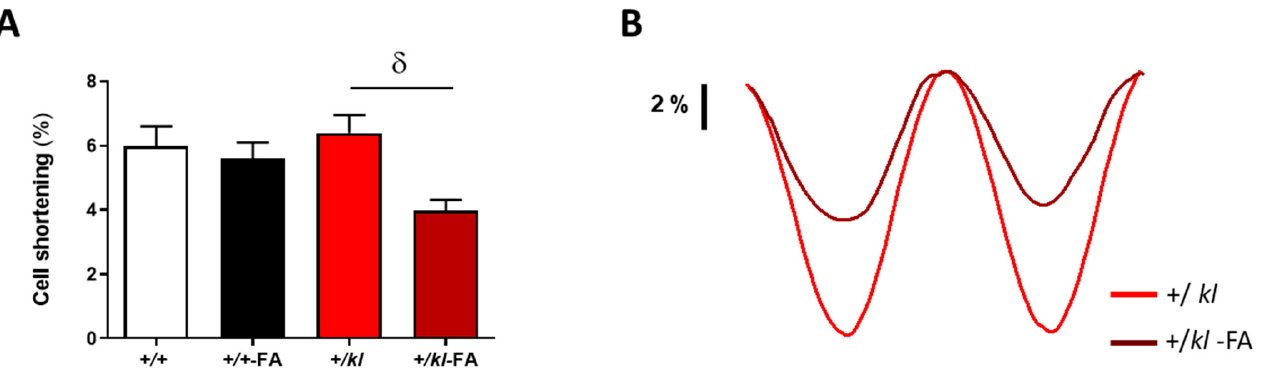
Figure 1. Partial klotho deficiency aggravates the cardiomyocyte contractile function after AKI. ( A ) Cell shortening of cardiomyocytes from wild-type +/+ (n = 48 cells, N = 5 mice), +/+-FA (n = 66 cells, N = 4 mice), +/ kl (n = 46 cells, N = 5 mice) and +/ kl -FA animals (n = 54 cells, N = 3 mice). ( B ) Shortening profiles examples of cardiomyocytes from +/ kl and +/ kl -FA mice. Data are expressed as mean ± SEM. δ p < 0.05 vs. +/ kl .